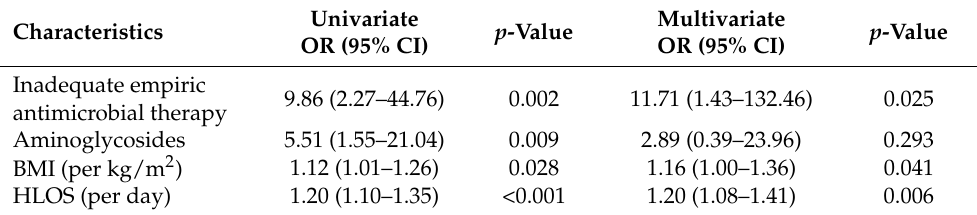
Table 4. Univariate and multivariate analysis of factors associated with therapeutic failure.